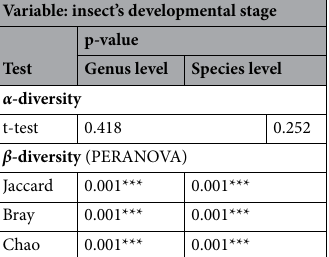
Variable: insect’s developmental